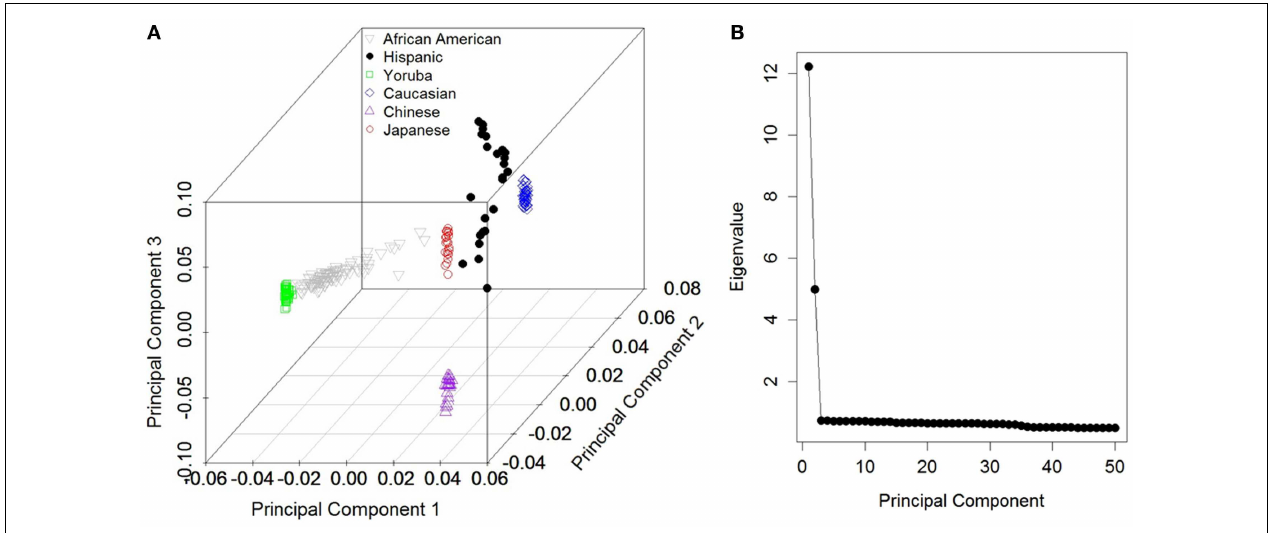
FIGURE 1 | (A) First three principal component scores based on all autosomal markers with post hoc groupings. (B) Scree plot depicting Eigen values for the first 50 components for the corresponding components in (A)